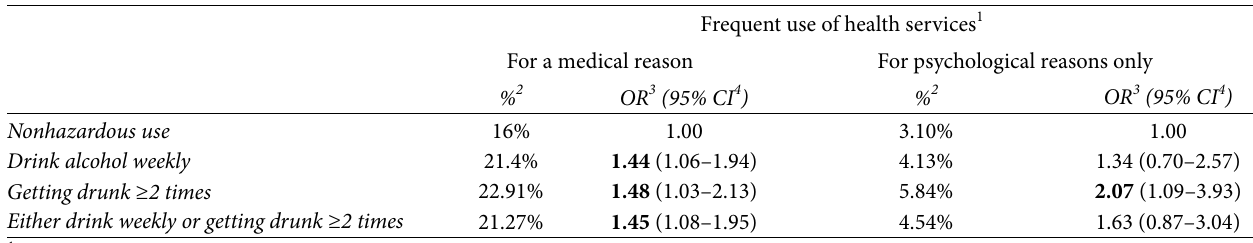
1 Frequent use of services defined as having visited (a) a family doctor for any medical reason ≥3 times during the past 12 months or (b) a family doctor or a mental health professional for a psychological reason at least once during the previous 12 months. 2 All percentages are weighted to account for the stratified random sam- pling; 3 Odds ratios are adjusted for age and sex and calculated from logistic regression models with frequent doctor visits as the dependent variable and hazardous alcohol use as the independent variable (e.g., the odds of frequent doctor visits for a medical reason was 1.44 times higher for participants with at least weekly alcohol consumption compared to participants with nonhazardous alcohol use); 4 CI: Confidence